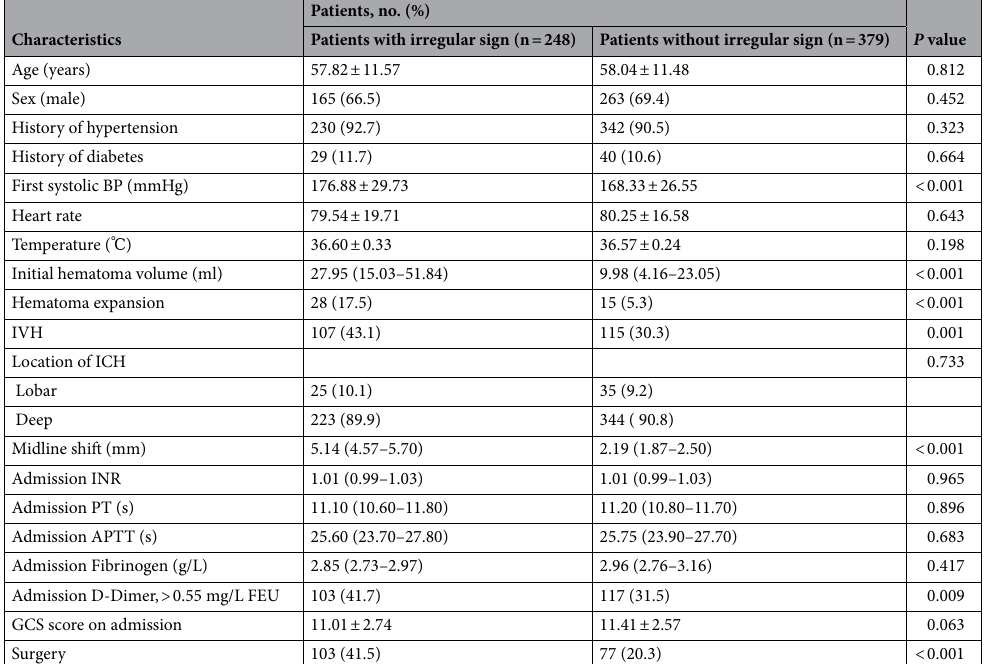
Table 1. Clinical characteristics related to Irregular Sign in patients with ICH. APTT = activated partial thromboplastin time, BP = blood pressure; GCS = Glasgow Coma Scale; ICH = intracerebral hemorrhage; INR = international normalized ratio; IVH = intraventricular hemorrhage on presentation; mRS = modified Rankin Scale; NIHSS = NIH Stroke Scale; PT = prothrombin time. Values are n (%), mean ± SD, or median (interquartile range).